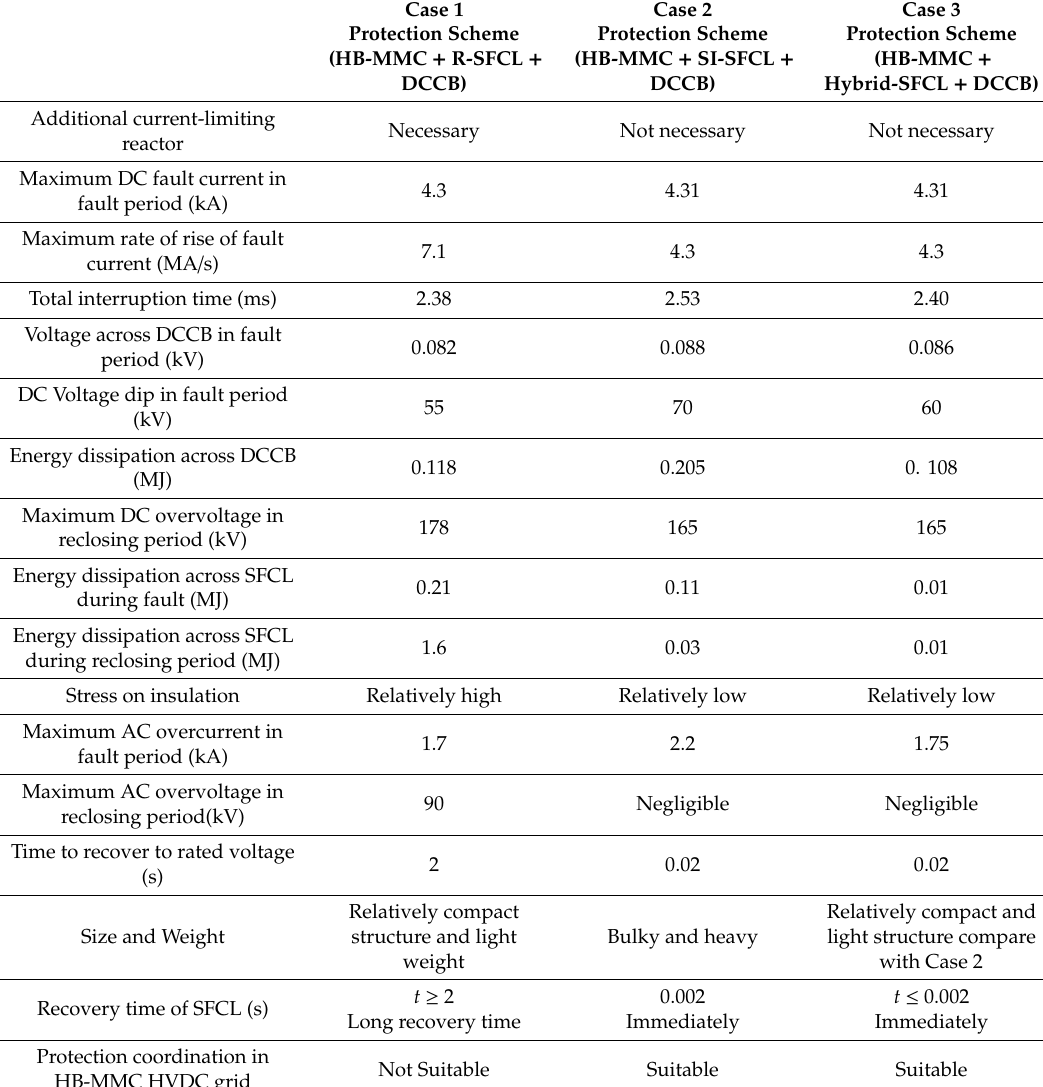
Table 2. Comparison of the three protection schemes for HB-MMC HVDC grid